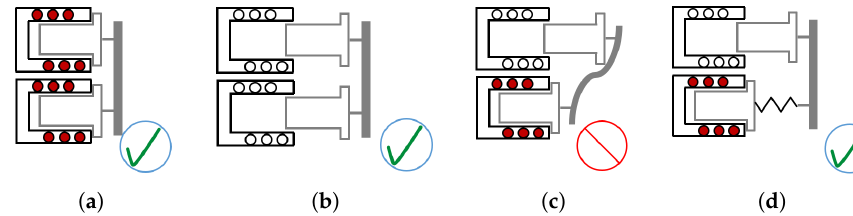
Figure 1. Modular, discrete muscle-like variable-stiffness actuator.